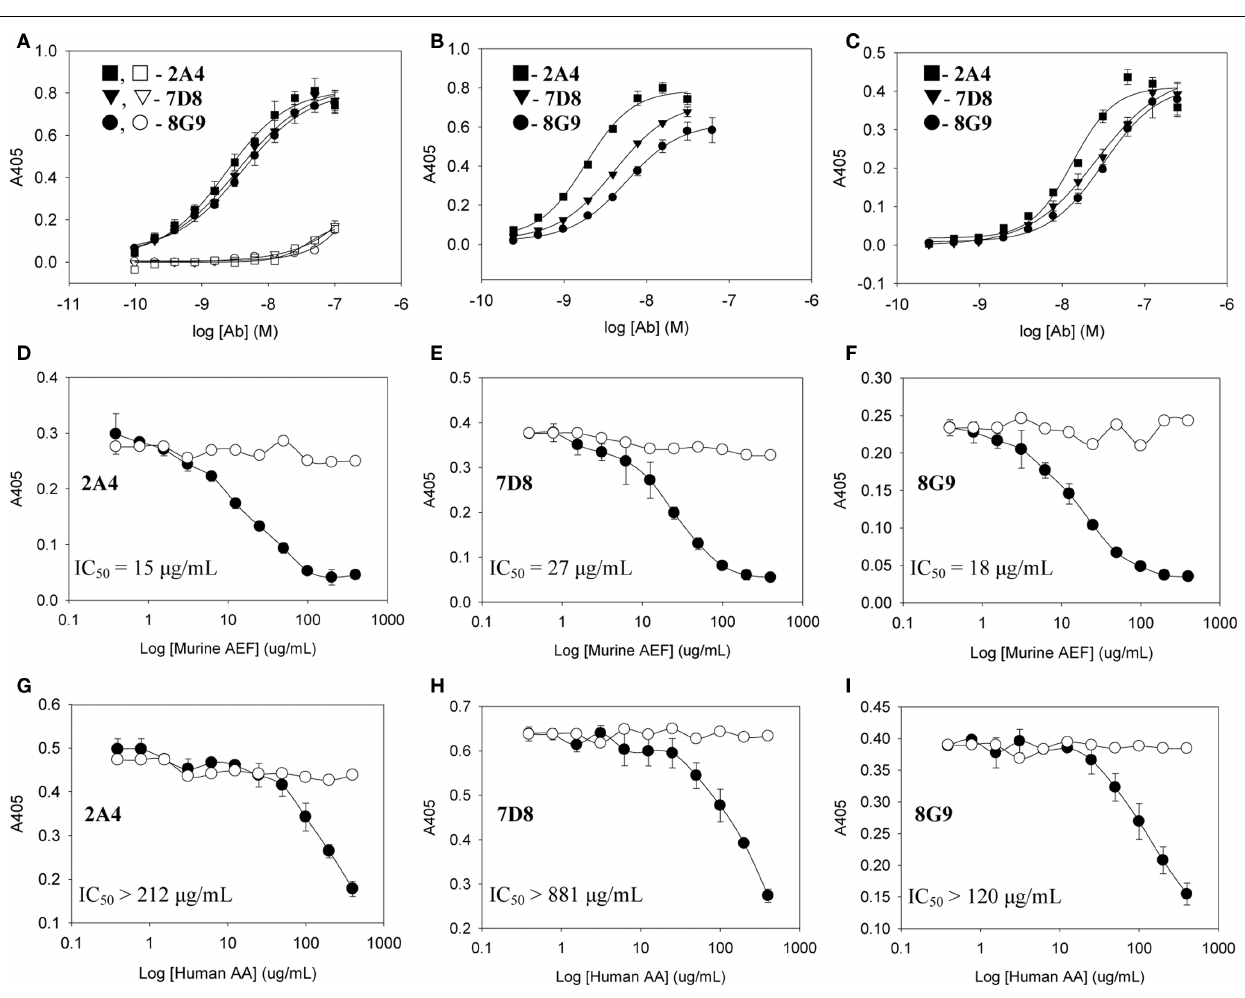
FIGURE 2 | Interactions of mAbs 2A4, 7D8, and 8G9 with murine and humanAA amyloid and syntheticAA-related peptides. (A) Binding of 2A4, 7D8, and 8G9 using GHEDT (filled) or, as a control for full length SAA, the GHEDTMADQE peptide (open), as substrate in the ELISA. (B,C) Reactivity of